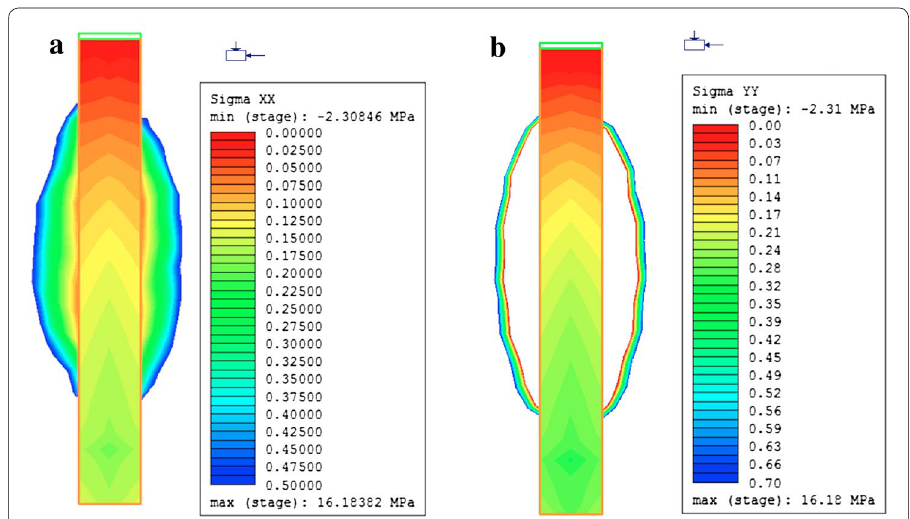
Fig. 4 Distribution of the induced horizontal stress ( a sigma xx (σ hz )) and vertical stress ( b sigma yy (σ vz ))